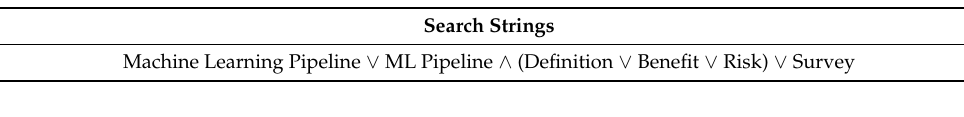
Table 6. Literature Review Search Strings—Blockchain.